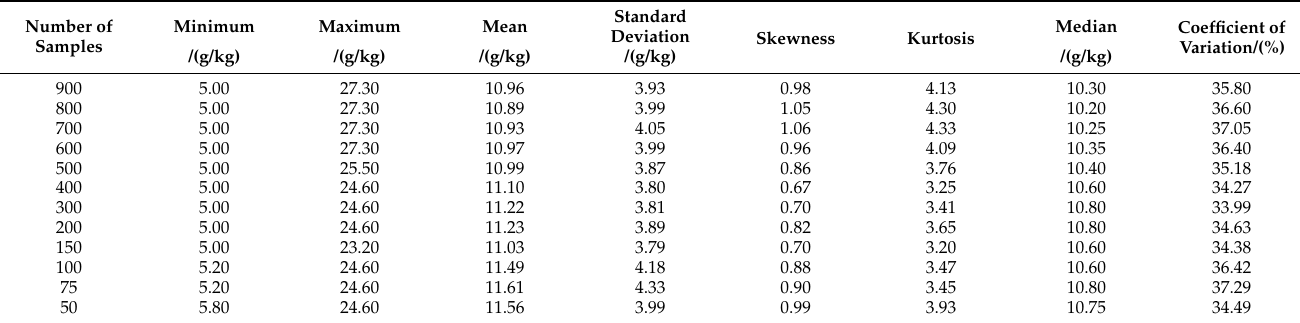
Table 1. Descriptive statistics of SOM content in different sampling